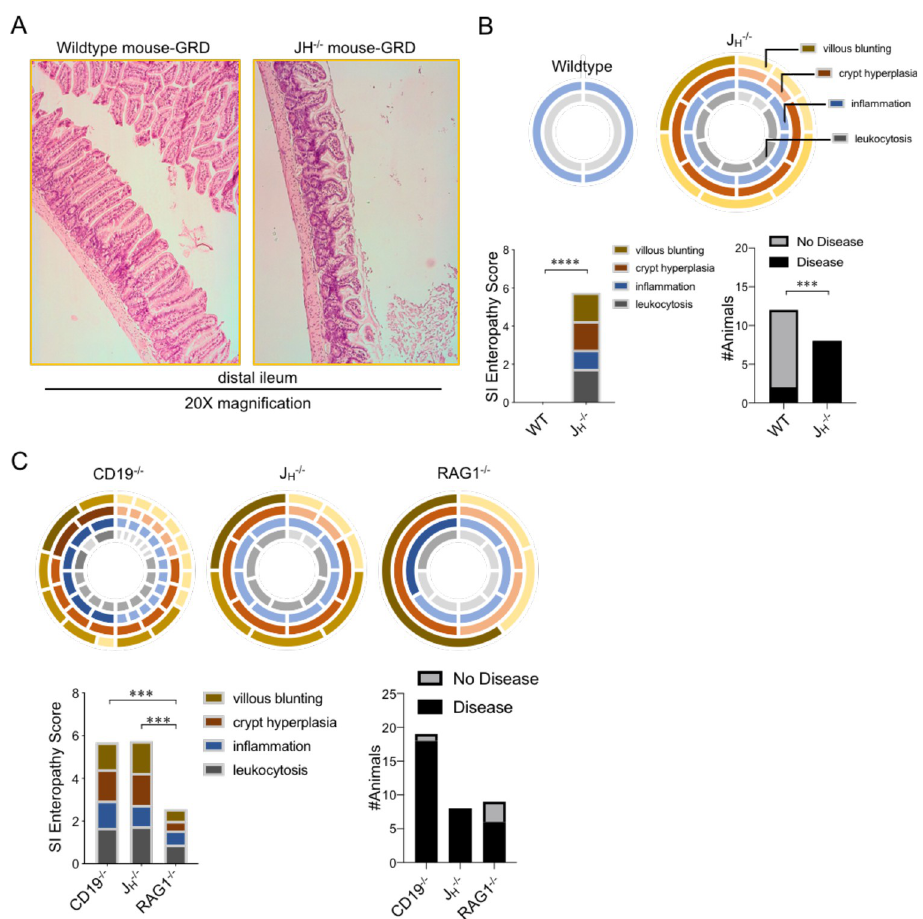
Fig 1. J H-/- mice develop a gluten-sensitive SI enteropathy, which is a T cell-dependent phenotype. (A) Representative H&E staining of WT and J H-/- mouse ileums are shown. (B) SI enteropathy scores and the incidence of detectable disease phenotypes are shown. The wheal diagrams depict the severity of disease (darker = more severe) for each of the four disease phenotypes (outlined in plot). Spokes (i.e. breaks) in the wheel denote the number of mice where a given phenotype was observed. (C) SI enteropathy scores and disease incidence comparisons are shown for J H-/- , CD19 -/- , and RAG1 -/- mice. (B and C) Two-way repeated measure ANOVAs were used to compare the effects of genotype on the severity of SI enteropathy, and a two-sided Fisher’s exact test was used to compare disease incidence, in both B and